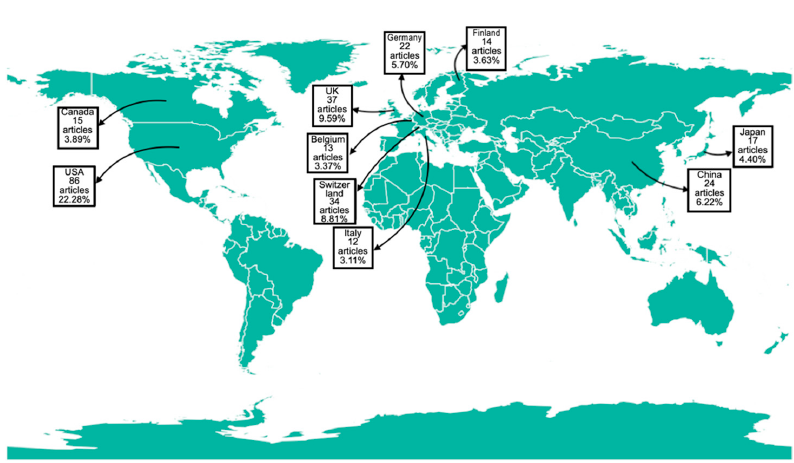
Figure 5. Distribution in countries/regions for contribution of the literature on BCG/SCG.